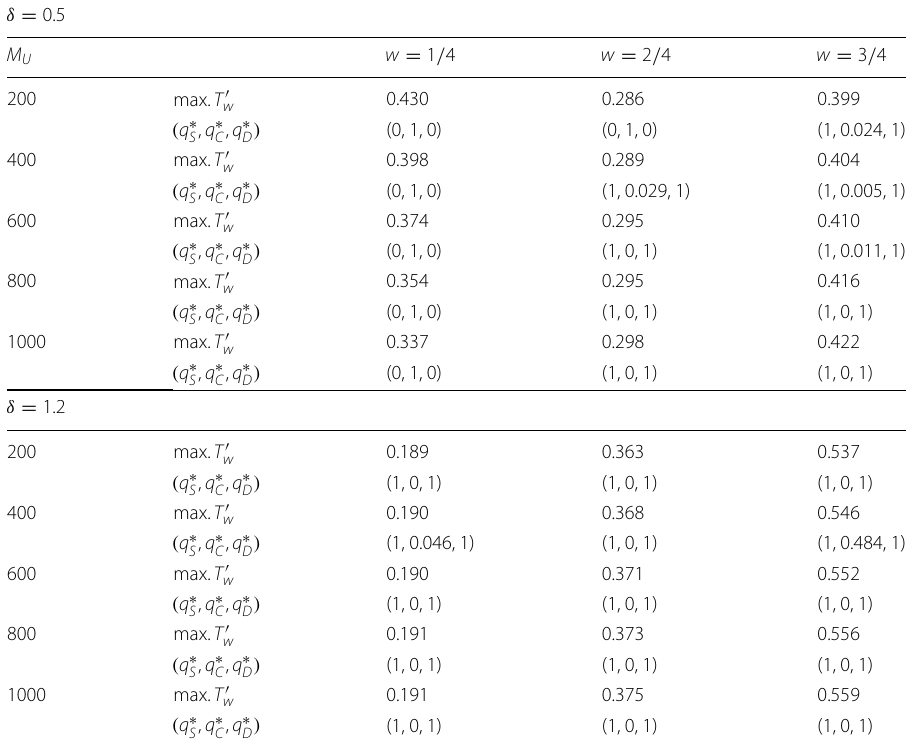
Table 7 The values of ( q ∗ of M U when α = 0.7 and the queue at S is unstable δ =